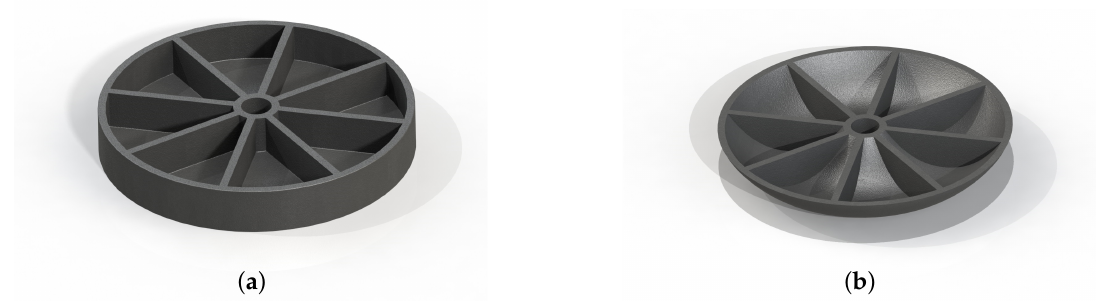
Figure 3. Examples of pan impellers. ( a ) Rectangular shape; and ( b ) rounded